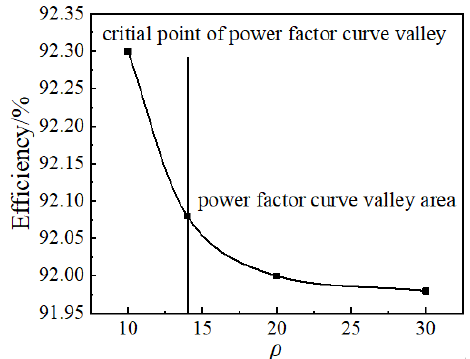
Figure 20. Efficiency curve with different ρ at λ = 0.5.